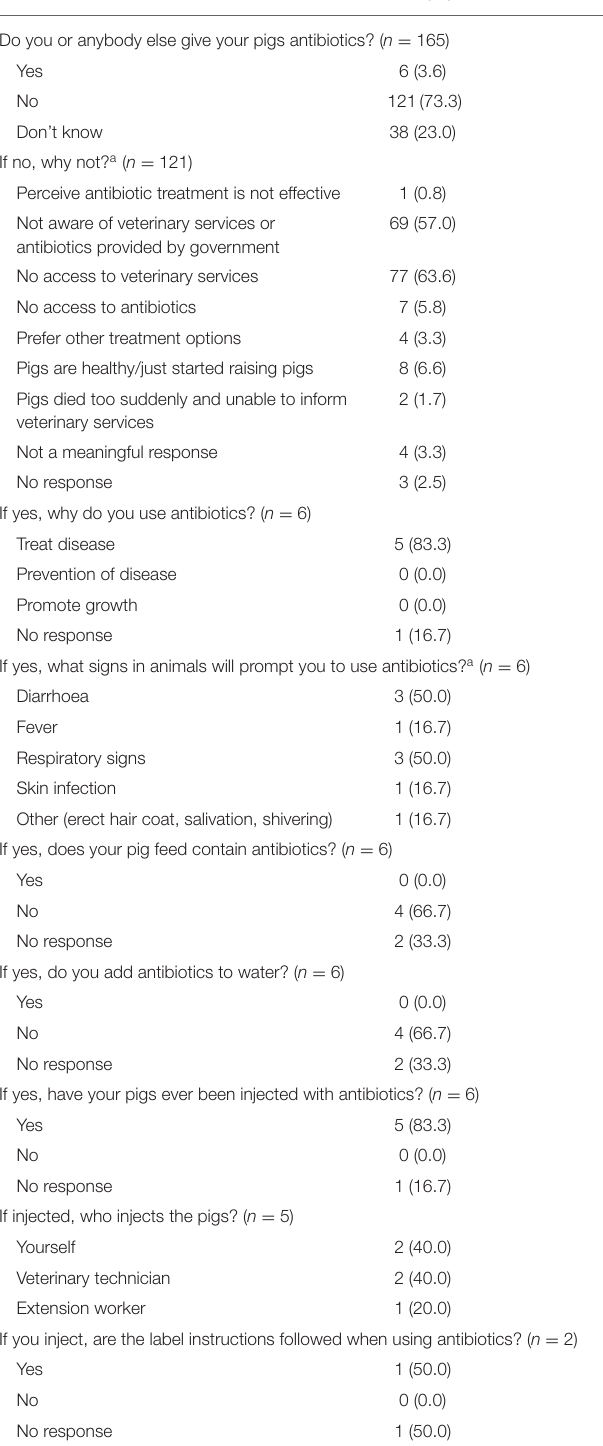
TABLE 2 | Practices on antibiotic use on smallholder pig farms in Timor-Leste in 2020.